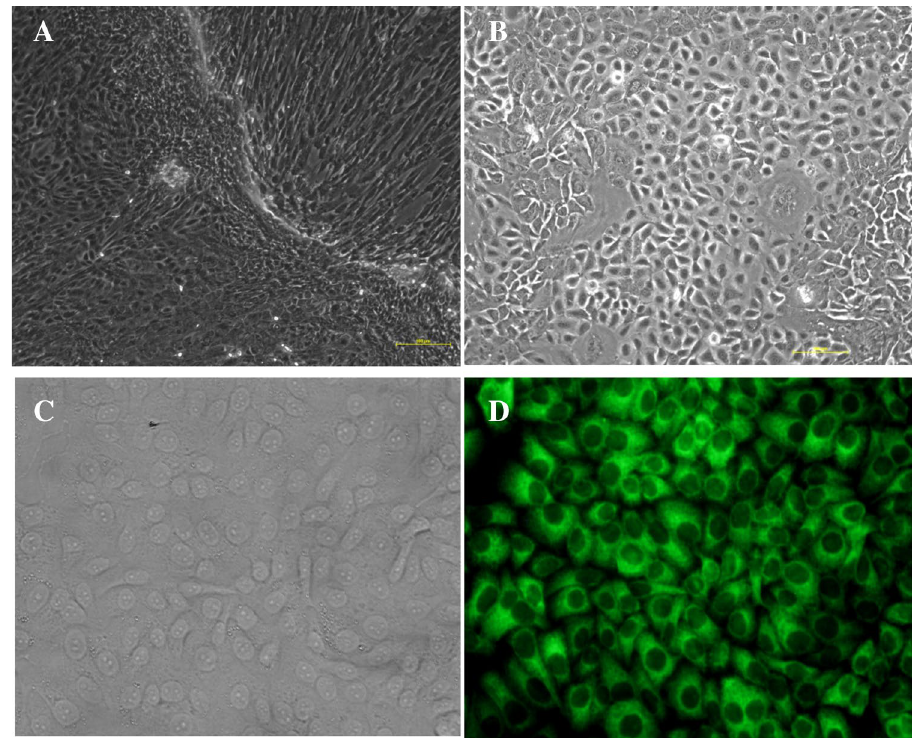
Figure 1. Photomicrographs of isolation, culture and identification of BMECs. ( A ) Mixed population of epithelial and fibroblast cells; ( B ) The BMECs purified three times; ( C ) Bright light image of BMECs stained with cytokeratin 18 (400 ×); ( D ) Fluorescent image of BMECs stained with cytokeratin 18 (400